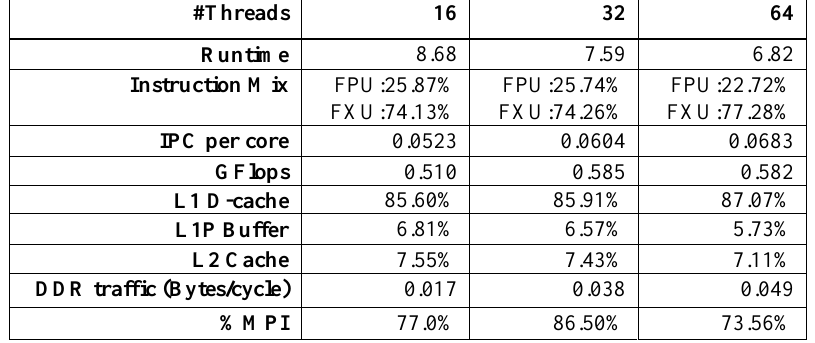
Table 5. Performance (per node) comparison of PMLB with the problem size of 256x256256 on 128